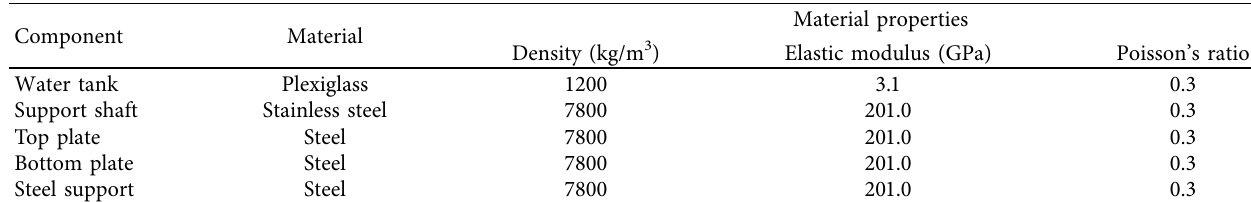
Table 3: Material parameters of experimental